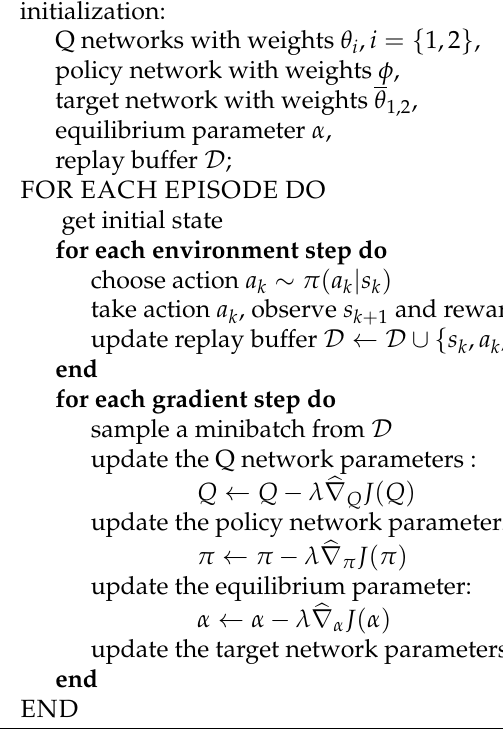
Algorithm 1 Soft actor-critic DRL with automating entropy adjustment